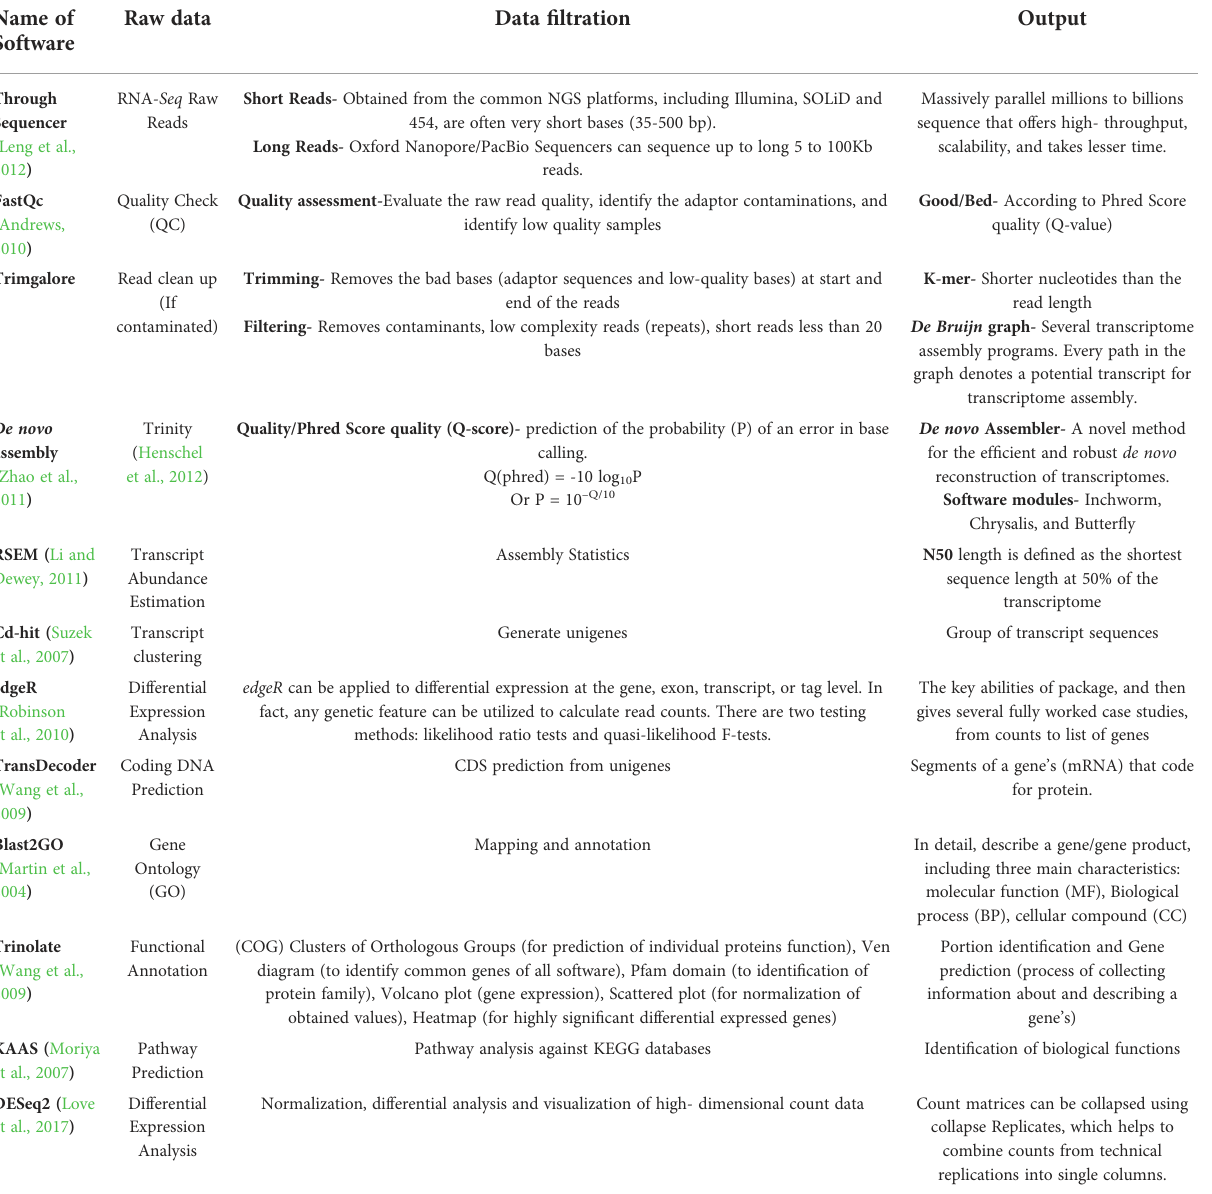
TABLE 2 List of softwares used in De novo assembly pipeline with their functions. Name of